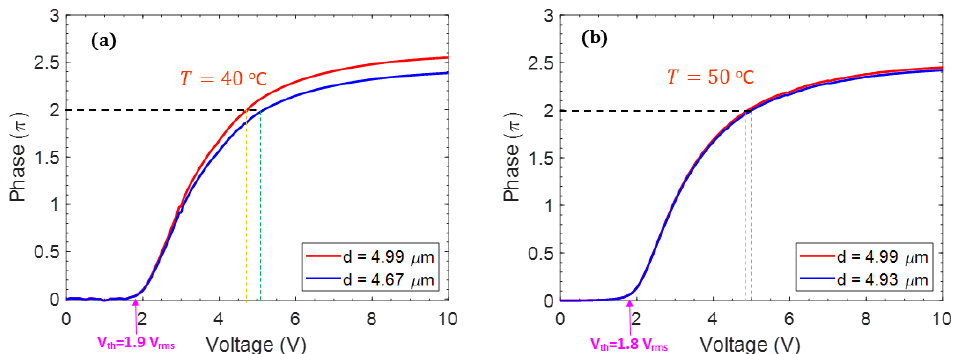
Figure 4. Measured (red line) voltage-dependent phase change of a transmissive TL-216 test cell at λ = 633 nm and 1 kHz. Cell gap is d = 4.99 µ m, with V 2 π = 4.7 V rms at T = 40 o C in ( a ) and with V 2 = 4.9 V rms at T = 50 o C in ( b ). If we operate TL ‐ 216 at 50 o C, we could use a slightly thinner cell gap (4.93 µ m transmissive cell or 2.47 µ m reflective LCoS, blue line in ( b )) to increase V 2 π to 5 V rms . Similar measurements and extrapolations apply to UCF ‐ 216 using a d = 5.01 m transmissive cell at = 633 nm. Figure 5a,b shows the measured and extrapolated voltage ‐ dependent phase change of UCF ‐ 216 at 40 o C and 50 o C. At 50 o C, as the red line shows, V 2 occurs at 3 V rms because of its higher n and lower threshold voltage (1.2 V rms ). Since our allowed V 2 is 5 V rms , we can reduce the cell gap to 4.14 m, as the blue line indicates in Figure 5b. For reflective mode operation, this corresponds to d = 2.07 m.